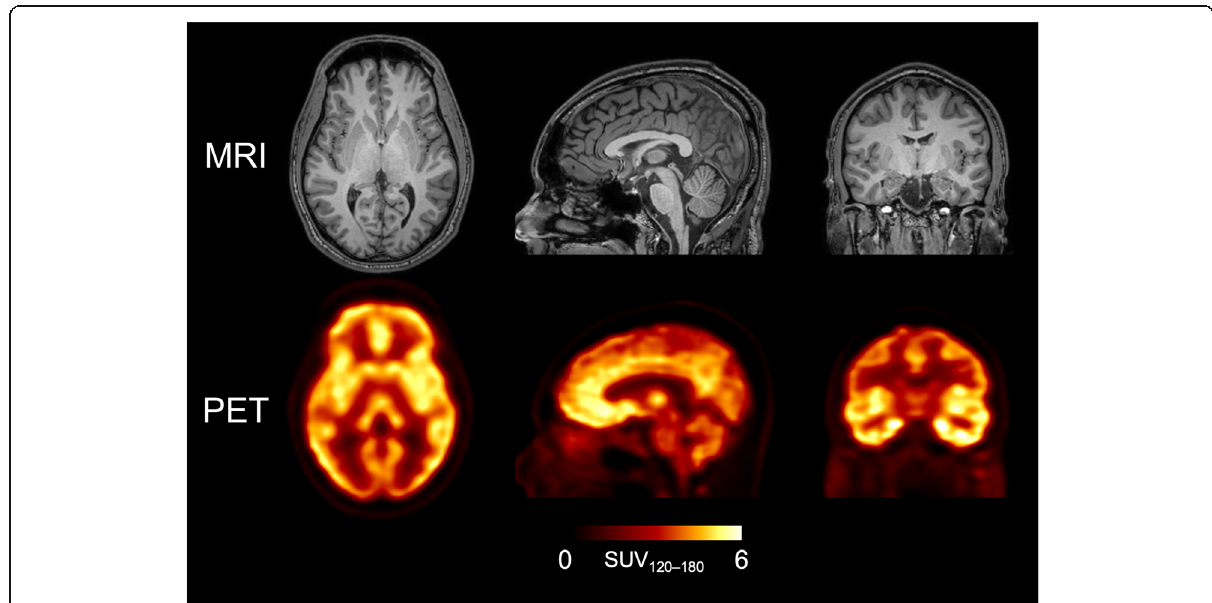
Fig. 1 T1-weighted magnetic resonance (MR) and [ 18 F]LSN3316612 positron emission tomography (PET) images of a healthy volunteer. Although the brain had high uptake of radioactivity, the skull had virtually none. The concentration of radioactivity in the brain is expressed as standardized uptake values (SUV), which was measured from 120 to 180 min